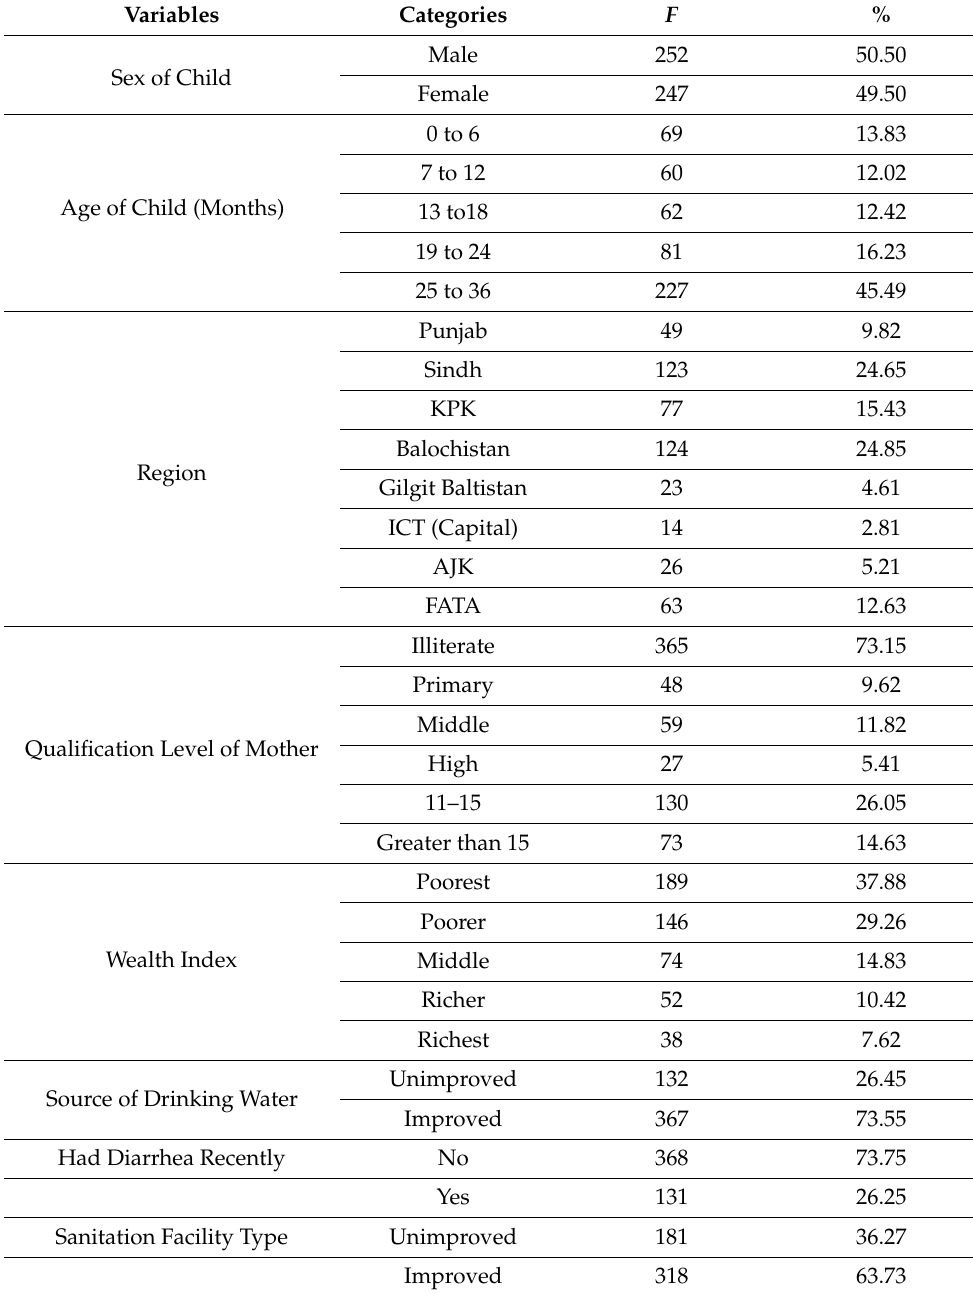
Table 2. Prevalence of malnutrition by different socio-economic